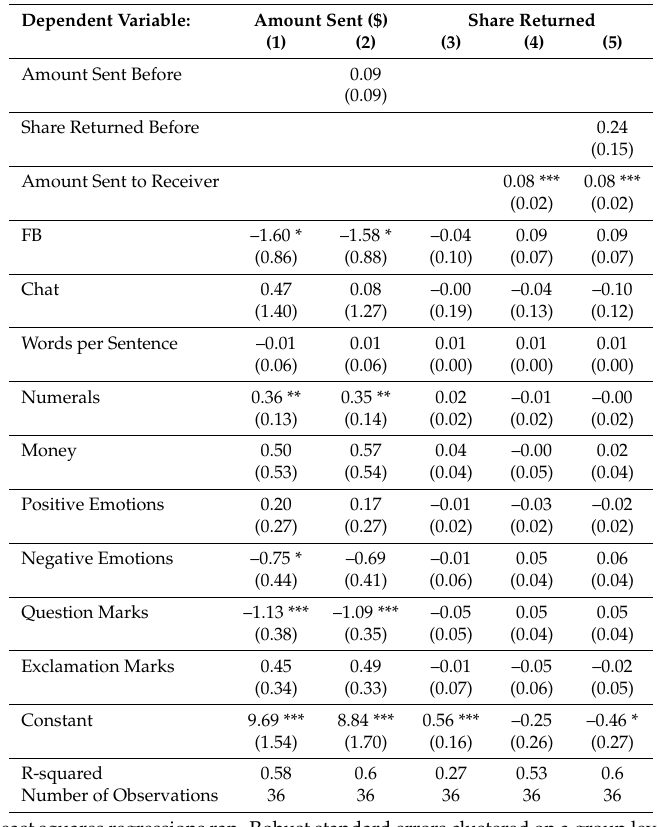
Table 10. Effects of communication on amount sent and returned